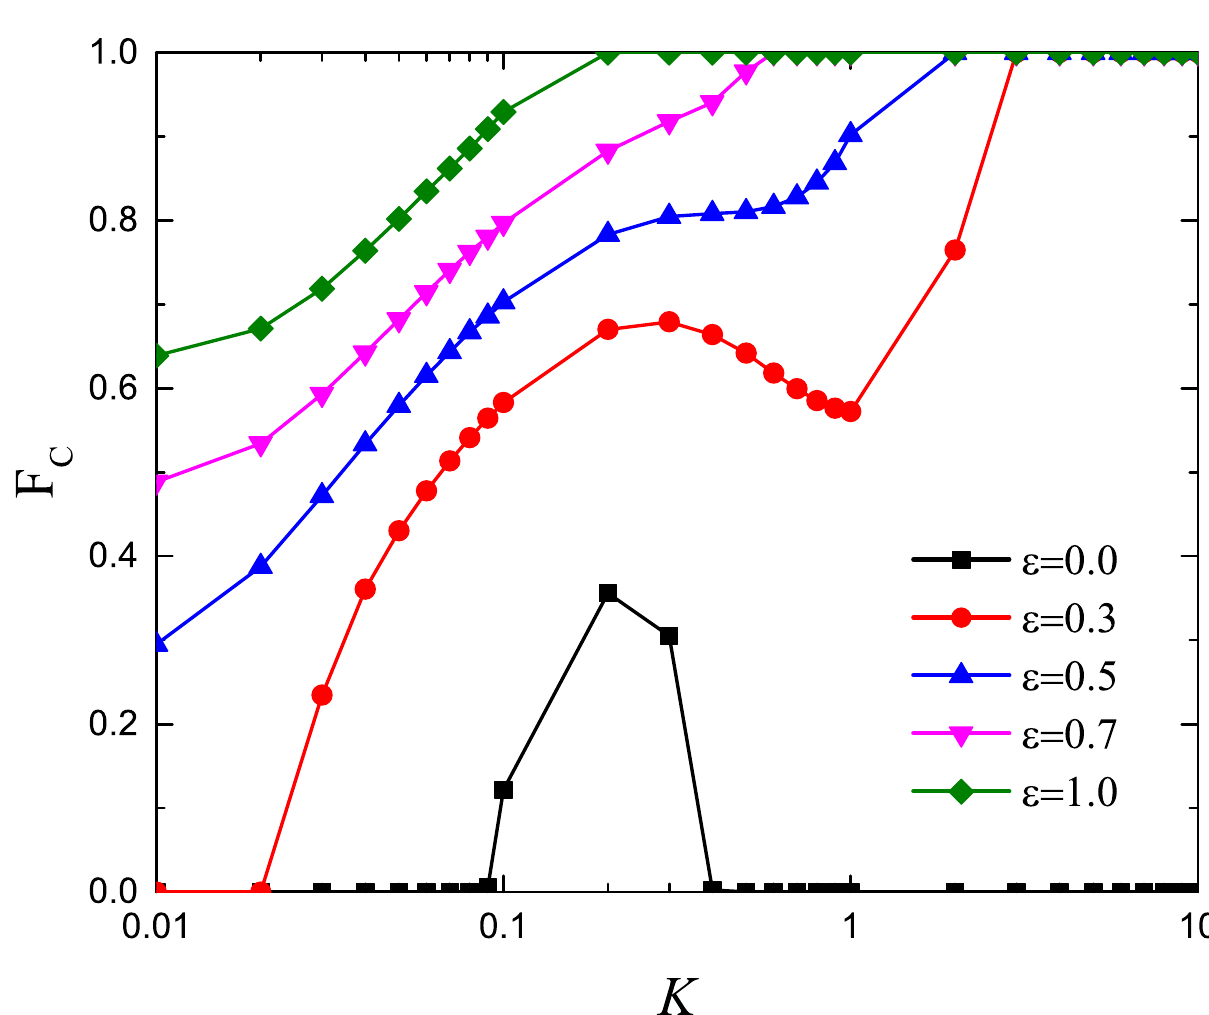
Fig 6. Effect of the amplitude of noise K on the fraction of cooperators F parameter b is fixed to 1.02.